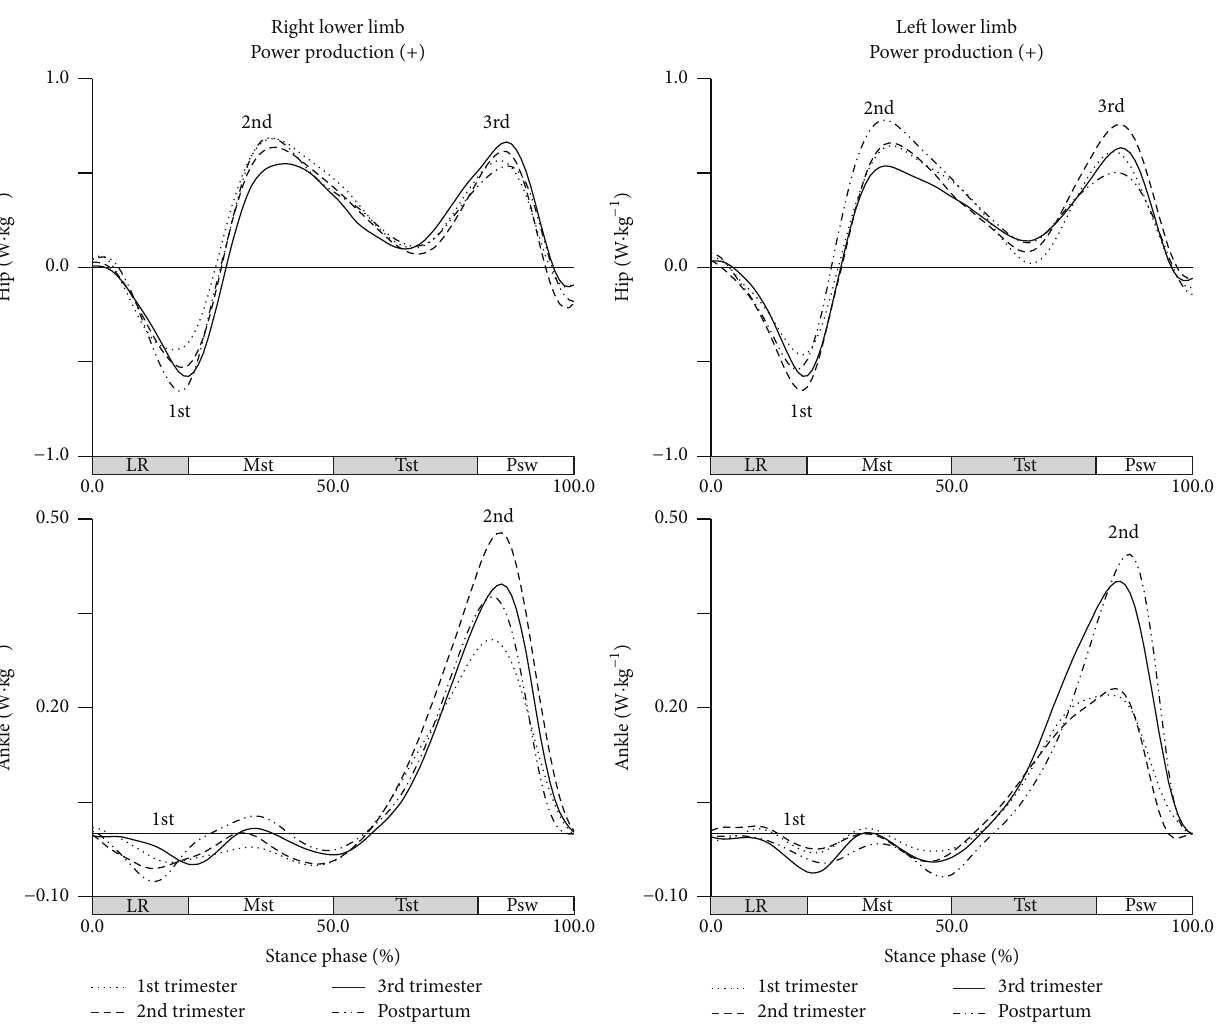
Figure 6: Joints power in the frontal plane during gait (in W ⋅ kg −1 ). Each line represents the later stages of first (dotted line), second (dashed line), and third trimesters (solid line) and of postpartum period (dash-dot-dot line). Mean joint powers of the hip and ankle, for right and left lower limbs. The curve peaks are Indicated by numbers: 1st, 2nd, 3rd, and 4th, and ( ∗ ) points the significant